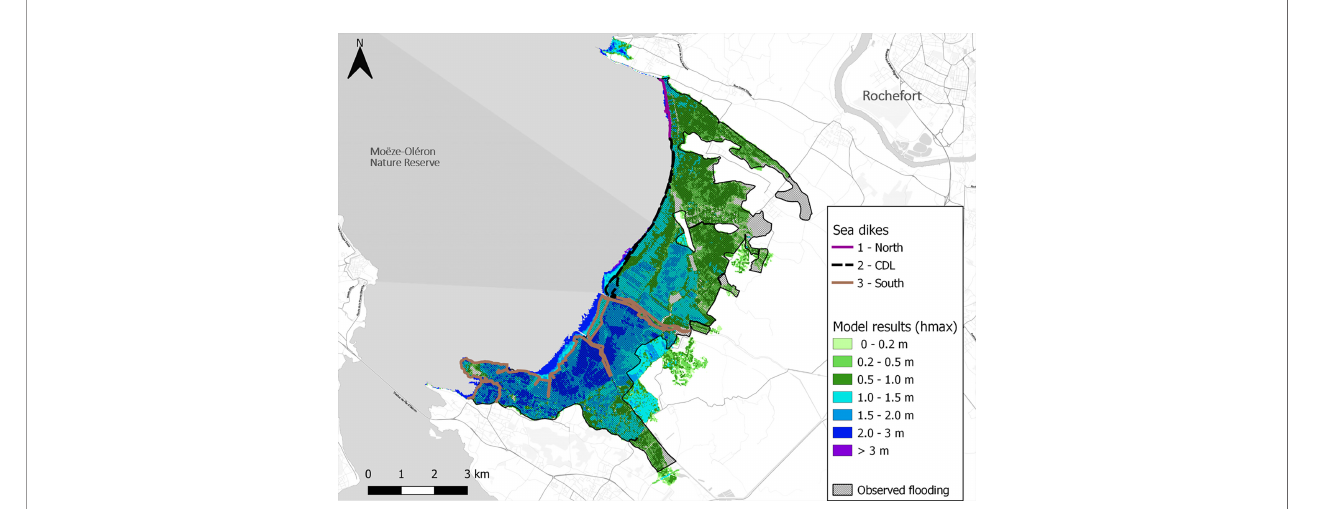
FIGURE 3 | Flooding extension area observed during storm Xynthia (2010) delimited in black and maximum heights simulated for storm Xynthia